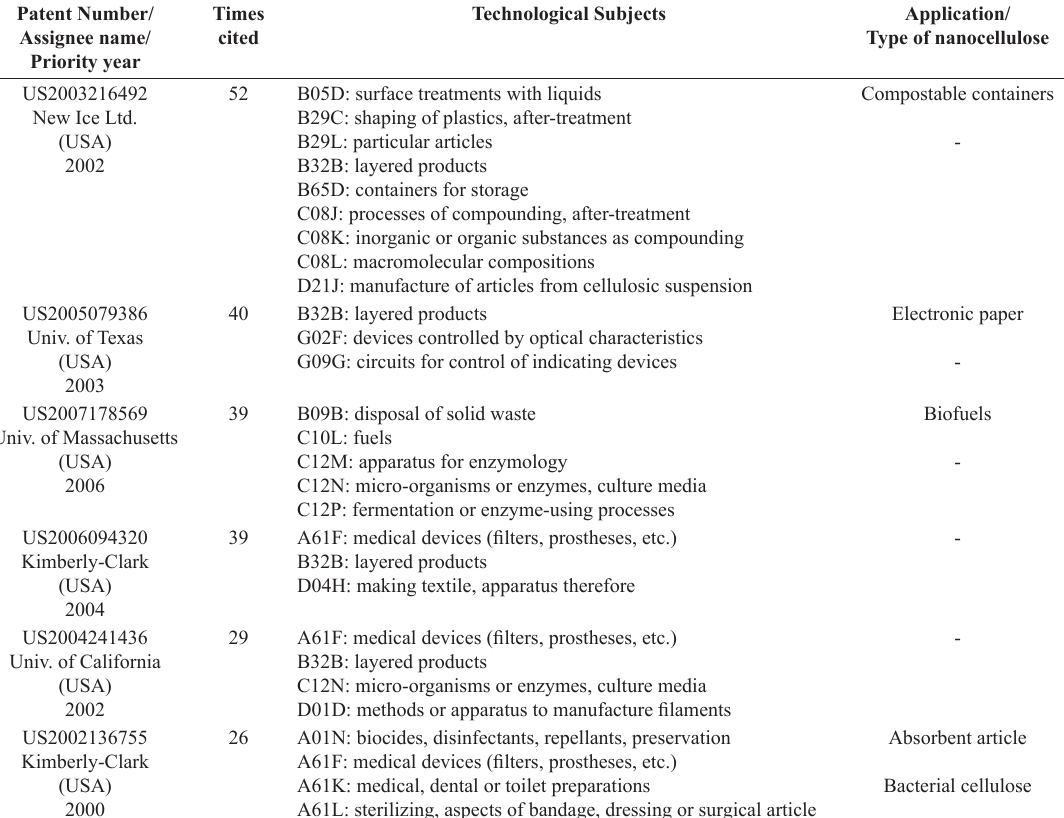
Table 3. Top 15 most cited patents profile from the sample